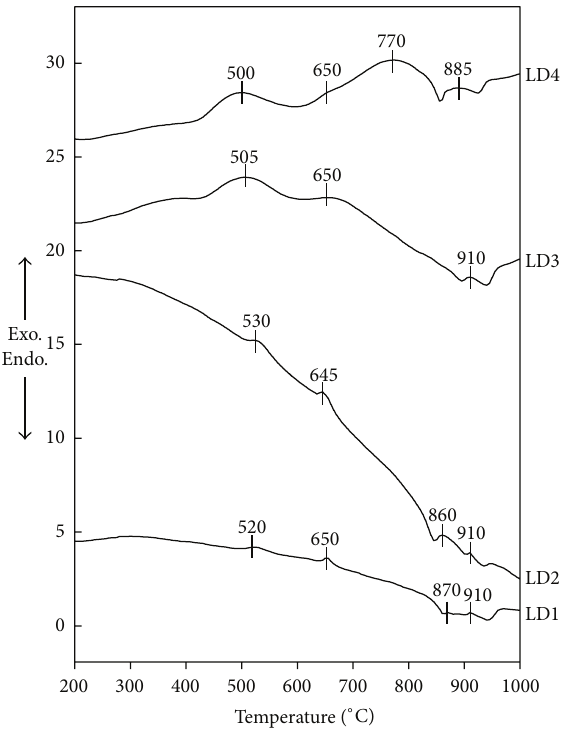
Figure 2: DTA traces of Glasses LD1–LD4.